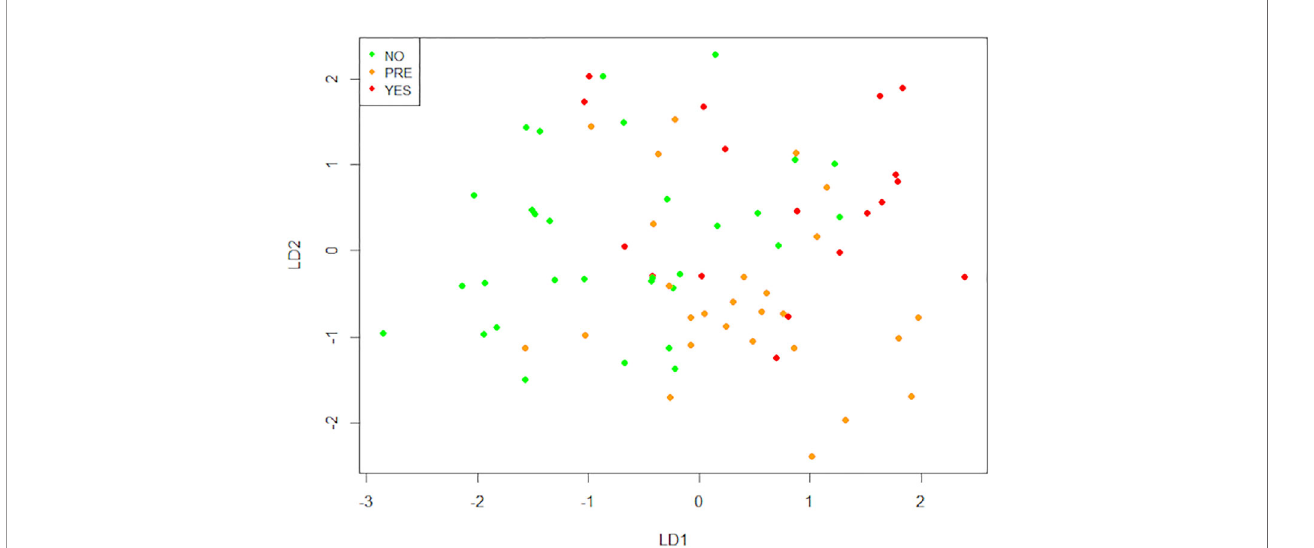
FIGURE 8 | Linear discriminant analysis (LDA). This technique fi nds the linear combinations of variables that better separate the observations. The data comes from the big cohort (n = 100). NO (patients without type 2 diabetes), PRE (patients with pre-type 2 diabetes), YES (patients with type 2 diabetes), LD1 (linear discriminant 1), LD2 (linear discriminant 2).